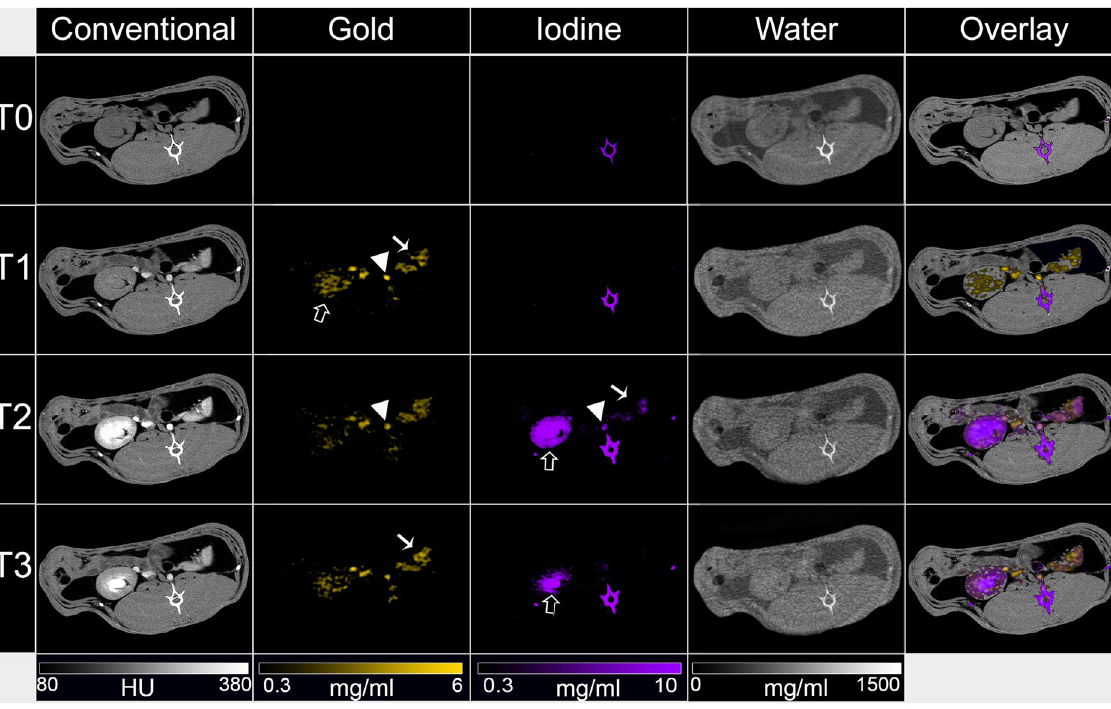
Figure 6. Photon-counting CT images of the abdomen of a rabbit. Conventional, gold, iodine, water and overlay images are shown for the three different time points. Arrowheads indicate aorta, white arrows indicate the spleen and black arrows indicate the